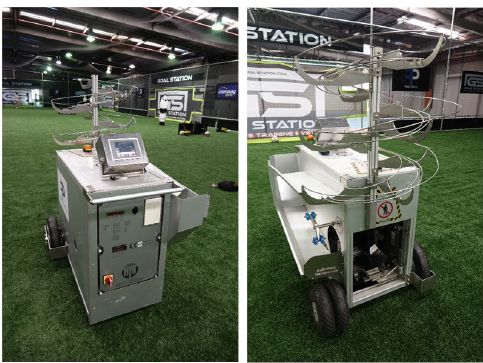
Figure 3. Ball Training Machine (BTM) by Ball Training Machine APS.